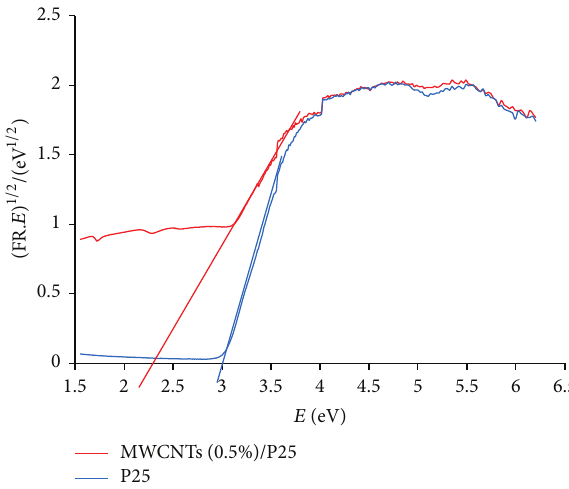
Figure 7: UV-visible Kubelka-Munk transformed diffuse reflectance spectra of P25 and MWCNTs/P25